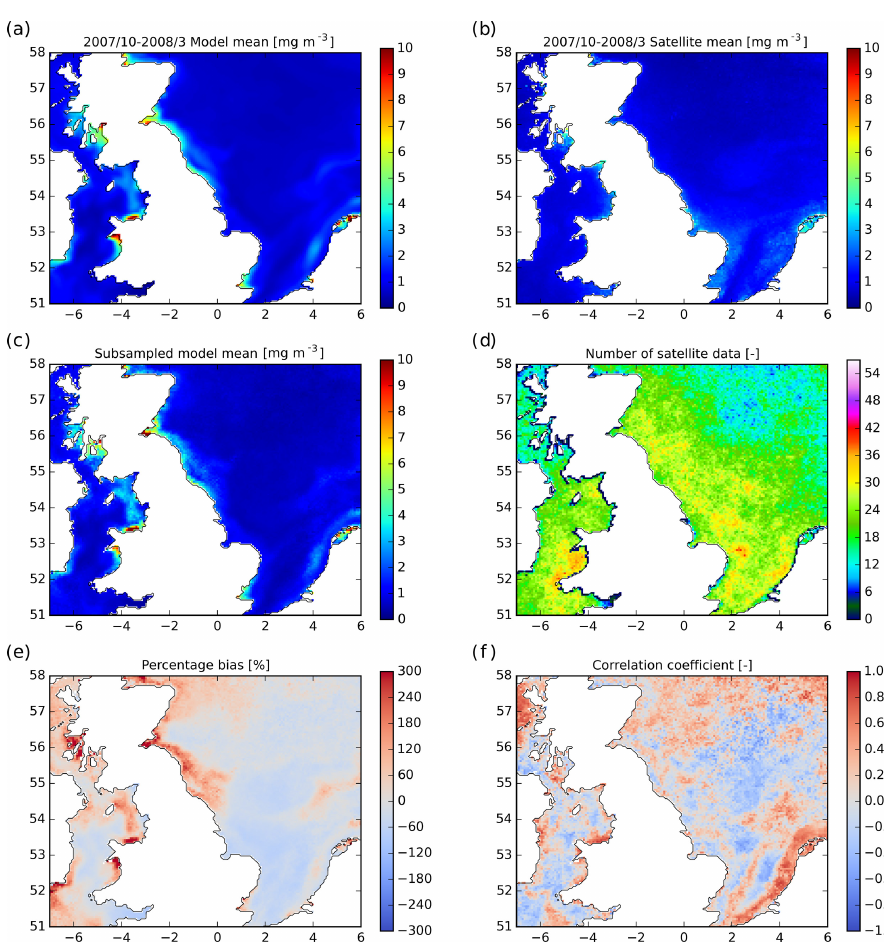
Figure 4. Comparison of winter chlorophyll- a concentrations between model and satellite (October 2007 to March 2008). (a) Model mean; (b) satellite mean; (c) model mean accounting for cloudy days; (d) number of clear days from satellite; (e) relative model bias; (f) correlation